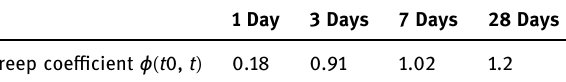
Table 1: Creep coe ffi cient variations